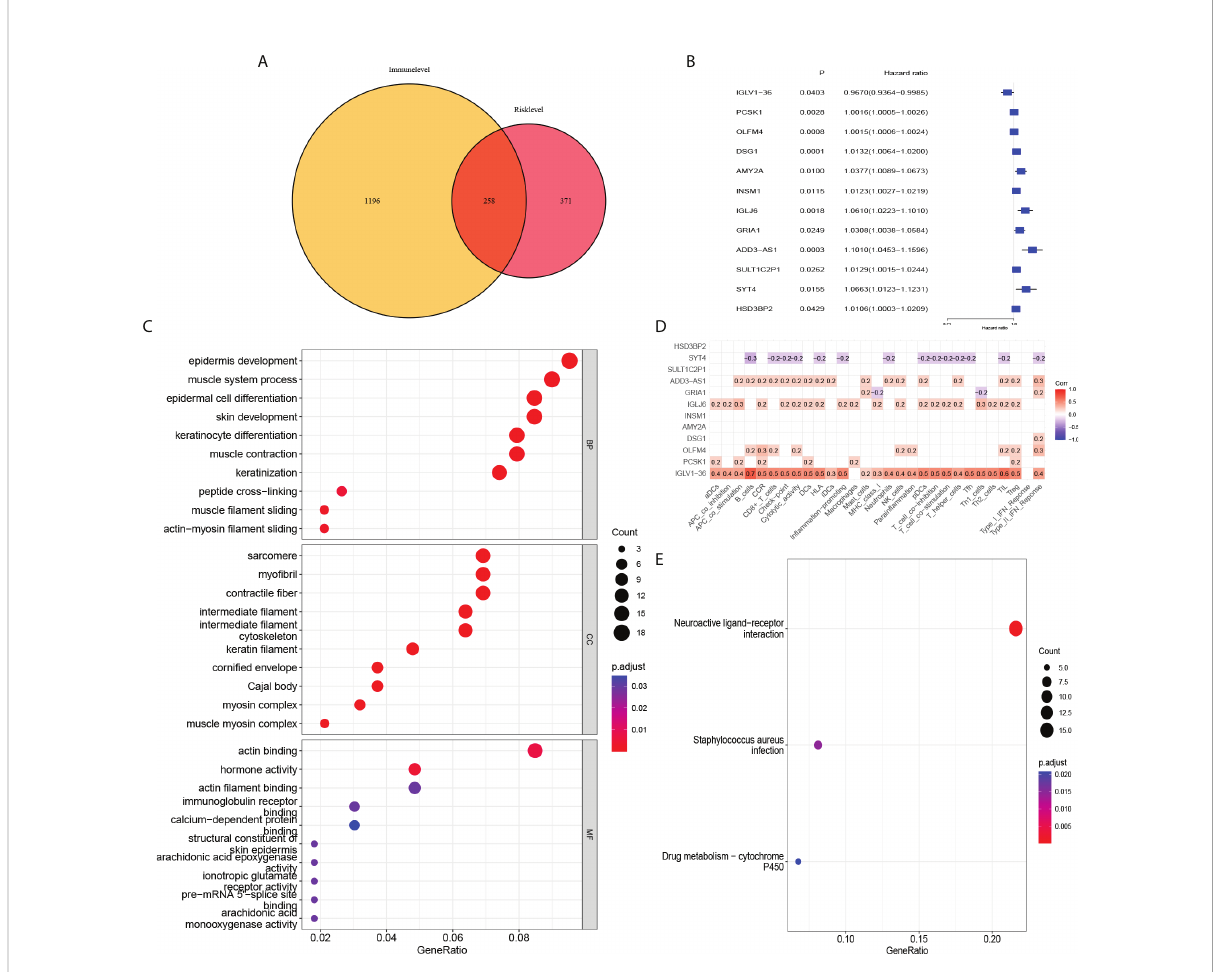
FIGURE 8 Association of risk level groups and mRNAs. (A) 258 mRNAs associated with risk level and immune in fi ltration were obtained. Subsequently, (C) GO enrichment analysis and (E) KEGG pathway enrichment analysis was performed. (B) By univariate Cox regression, 12 mRNAs were found to have effects on prognosis. (D) Correlation analysis of 12 mRNAs and immune in fi